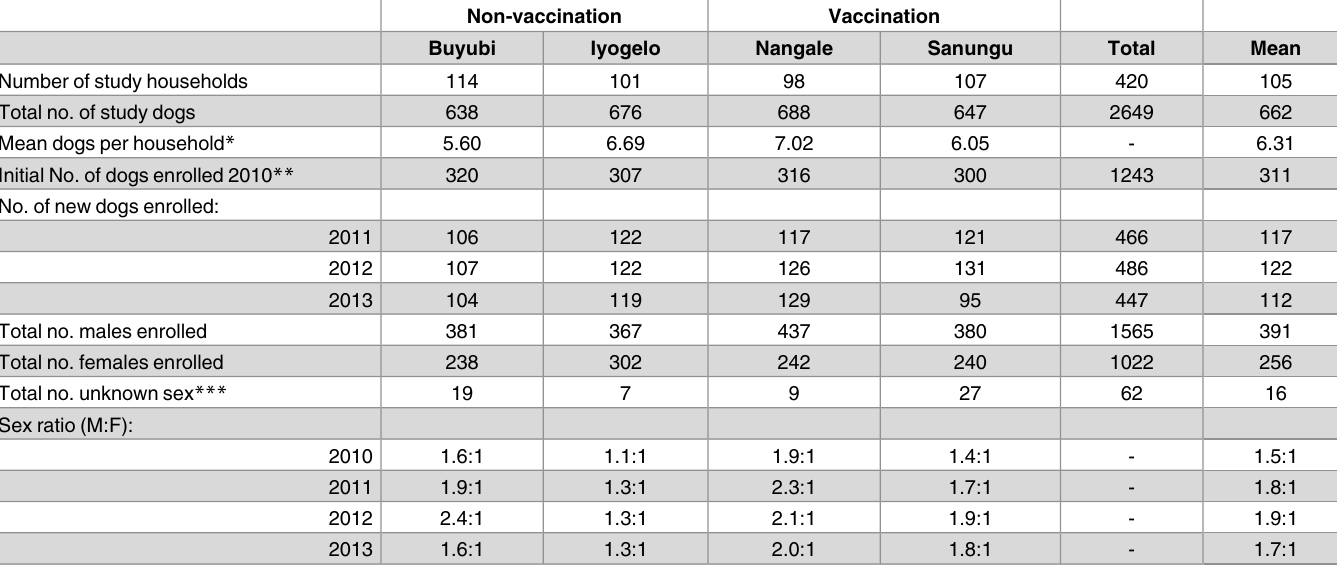
Table 1. Numbers of dogs and households enrolled in each village